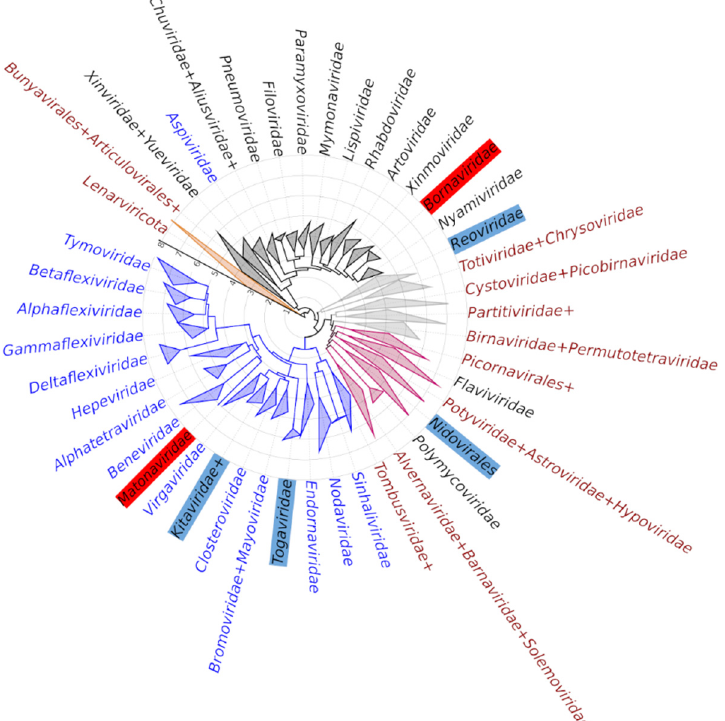
Figure 3. The distribution of methyltransferases among the families within the realm Riboviria tree. The tree is based on the most recent update of the megataxonomy of Riboviria and is constructed from the alignment of more than 6000 virus RNA-directed RNA polymerases (71); for the purpose of this visualization, the clades have been collapsed at the family level or occasionally at the order level. Some colors used for coding the clades (the inner circle) and the text labels (the outer circle) are slightly similar, but the coding schemes are different, and are as follows. The clades, counterclockwise from 10 o’clock: golden, Branch I; dark gray, Branch V; light gray, Branch IV; magenta, Branch II; blue, Branch III. The text labels: maroon, virus families that do not encode methyltransferases; dark gray, virus families encoding RrmJ-like methyltransferases; blue, virus families encoding Sindbis-like methyltransferases; black on blue, virus families encoding two different methyltransferases; black on red, unconfirmed methyltransferase domains in Bornaviridae and Matonaviridae . The concentric grid and the axis pointing at 10 o’clock indicate the tree scale, measured in the average number of substitutions per